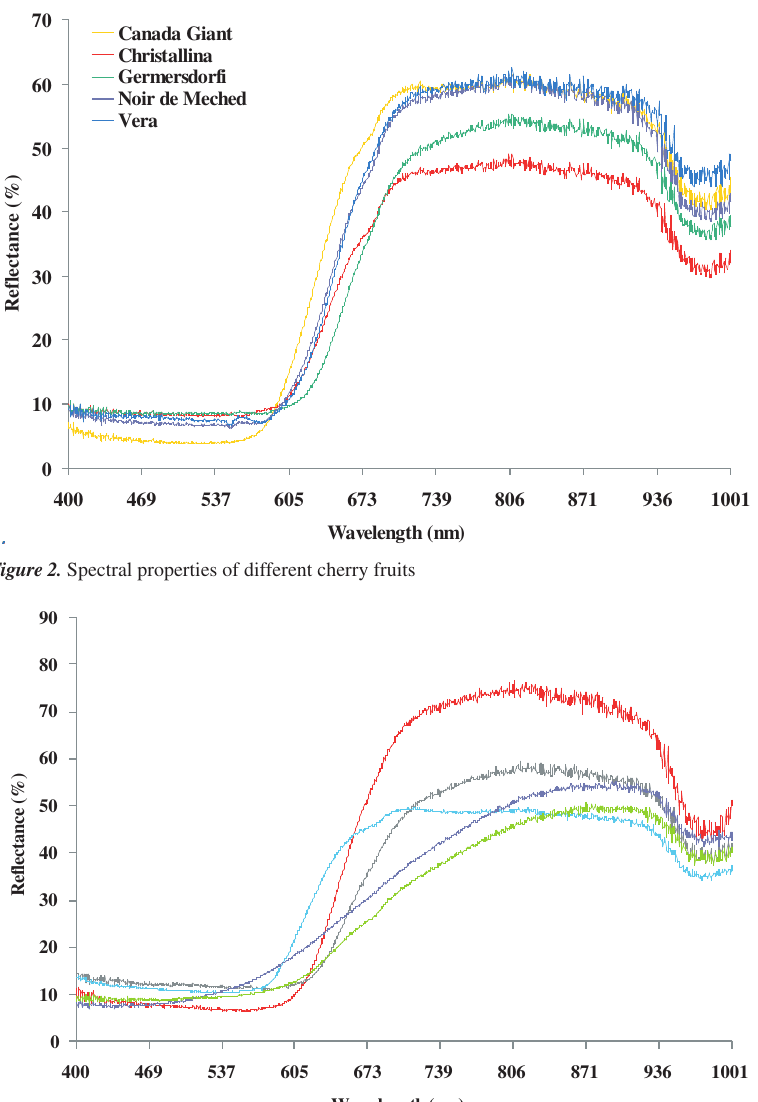
Figure 1. The AvaSpec 2048 spectrometer